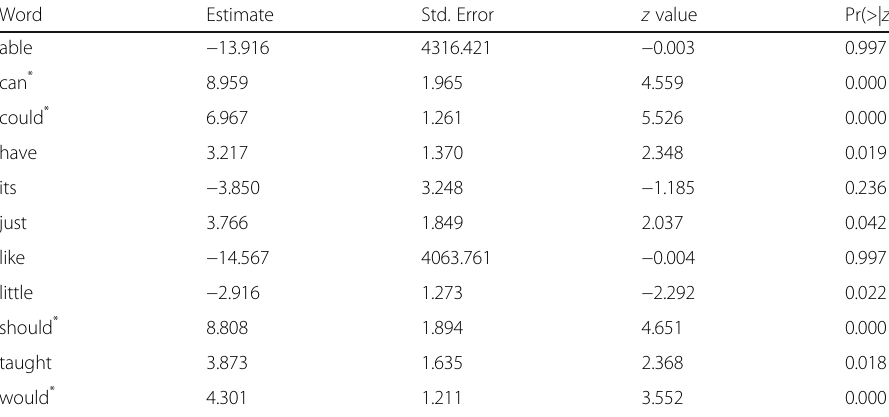
Table 3 Linear model outcomes on sample student comments